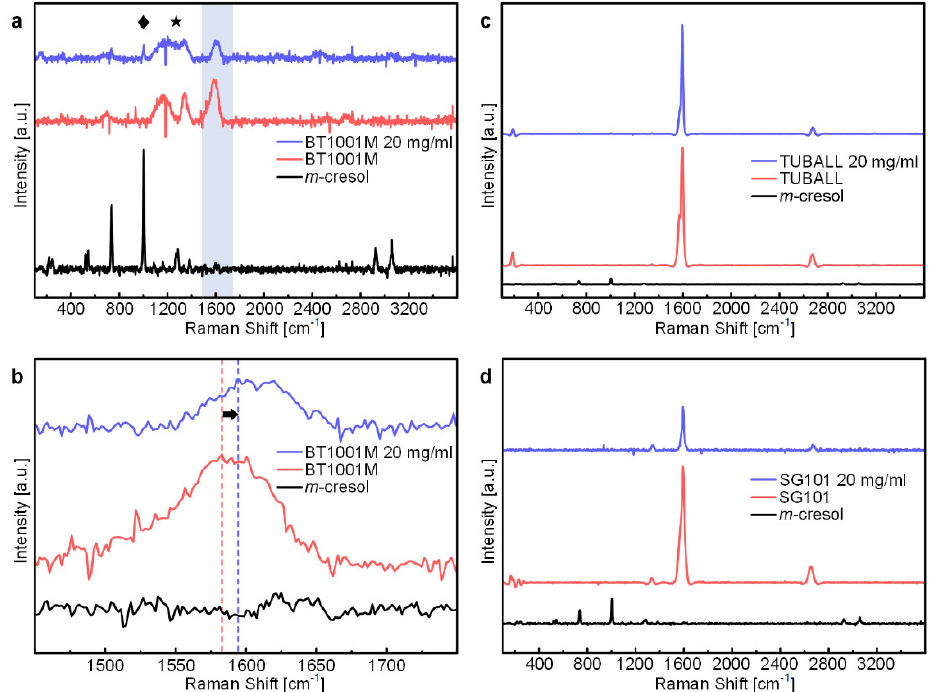
Figure 5. ( a ) Raman spectra of BT1001M/ m −cresol mixture (20 mg/mL), BT1001M, and m −cresol. The diamond, star, and blue region indicate Raman shift ranges, those are the Raman spectrum of m −cresol affects that of BT1001M. ( b ) Magnified Raman spectra of the blue region (1450−1750 cm −1 ) of ( a ). ( c ) Raman spectra of TUBALL/ m −cresol mixture (20 mg/mL), TUBALL, and m −cresol. ( d ) Raman spectra of SG101/ m −cresol mixture (20 mg/mL), SG101, and m −cresol.